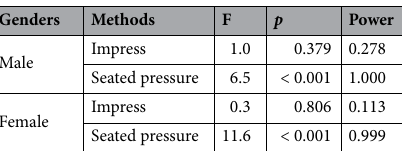
Table 3. Main effects of trunk–thigh angle on external ischial tuberosity width